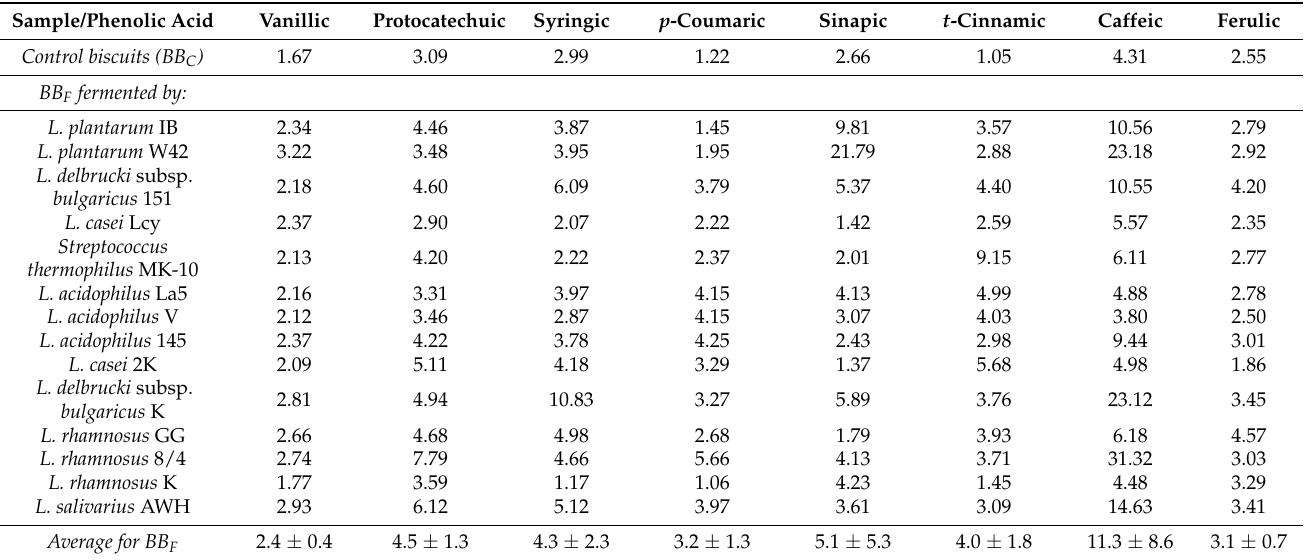
Table 3. The bioaccessibility indexes (BI) of phenolic acids from buckwheat biscuits prepared from unfermented (BB C ) and fermented flours (BB F ) by selected lactic acid